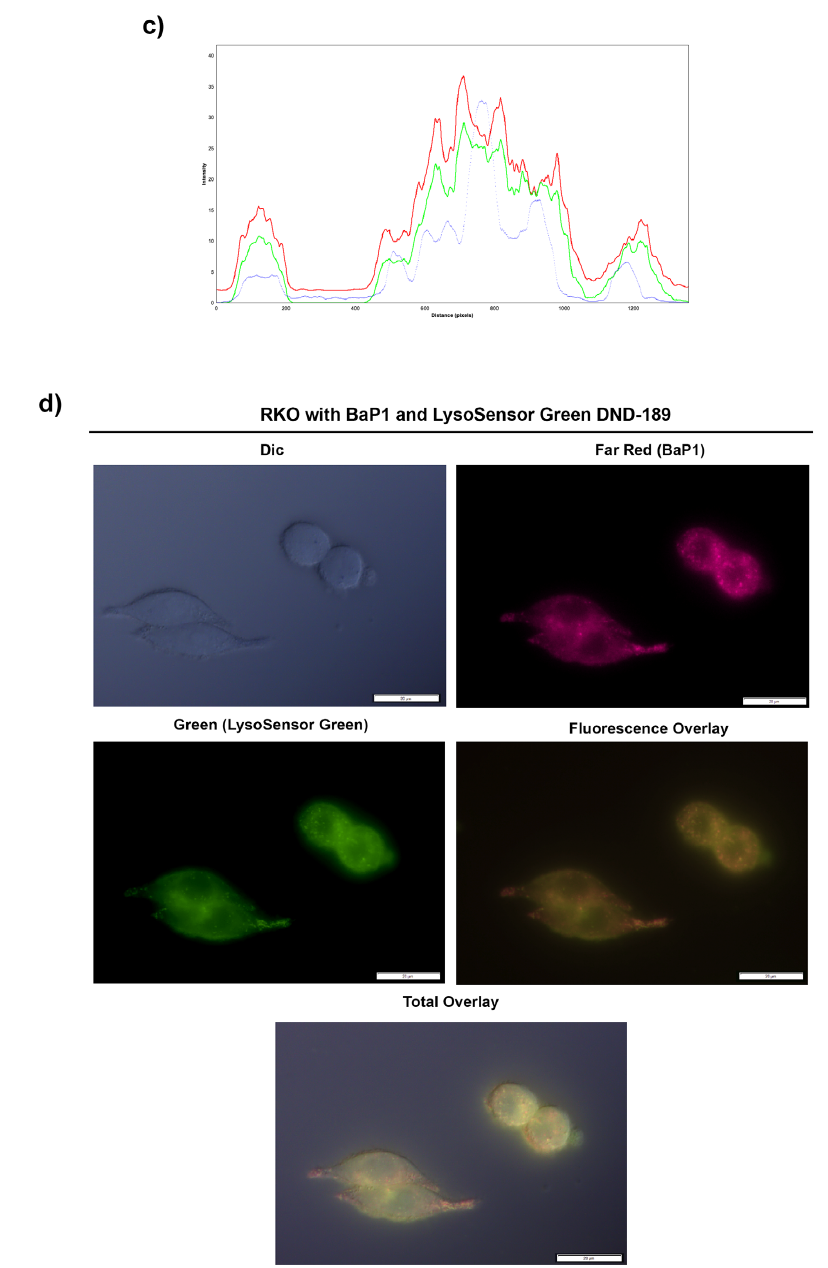
Figure 6. BaP1 lysosome accumulation. ( a ) Fluorescence microscopy images of RKO cells after incubation with BaP1 (0.35 µ M). ( b ) Florescence microscopy images of RKO cells after incubation with BaP1 (0.35 µ M), cells were stained with acridine orange (AO), represented as cyan blue (final concentration 1 µ M) and co-stained with DAPI (final concentration 10 µ g/mL). ( c ) RGB fluorescent emission profile of BaP1 (red line) AO (green line) and DAPI (blue line) overlay ( d ) Florescence microscopy images of RKO cells after incubation with BaP1 (0.35 μM), cells were stained with Ly- soSensor Green DND-189 (final concentration 2 μM).